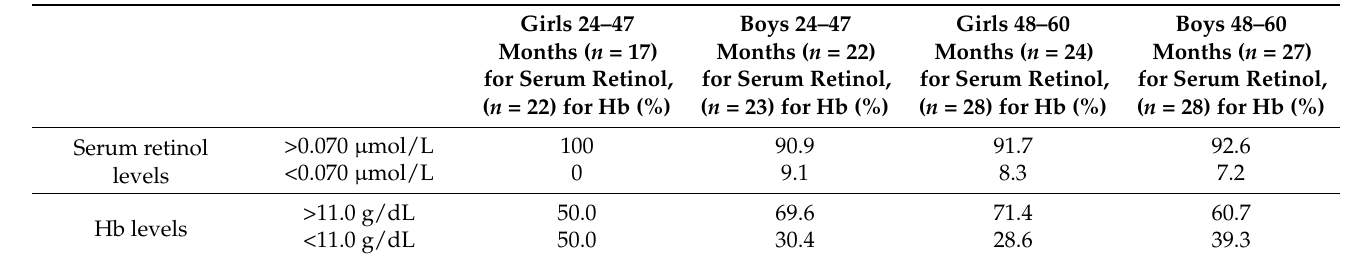
Table 4. Serum retinol ( n = 90) and Hb ( n = 101)